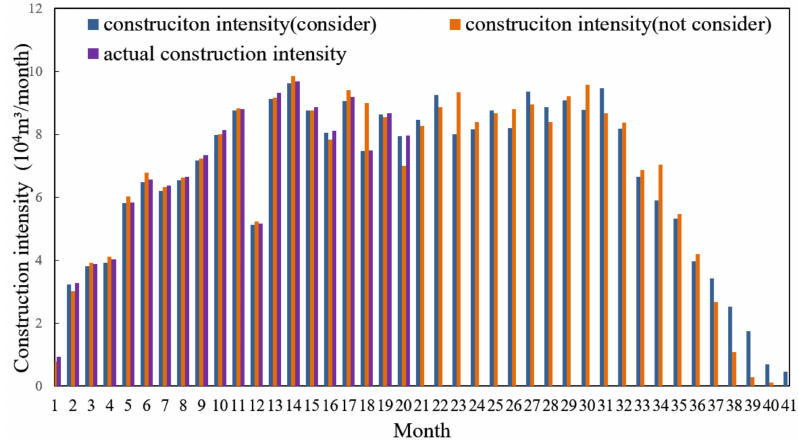
Figure 10. The comparison of the construction intensity with and without the temperature